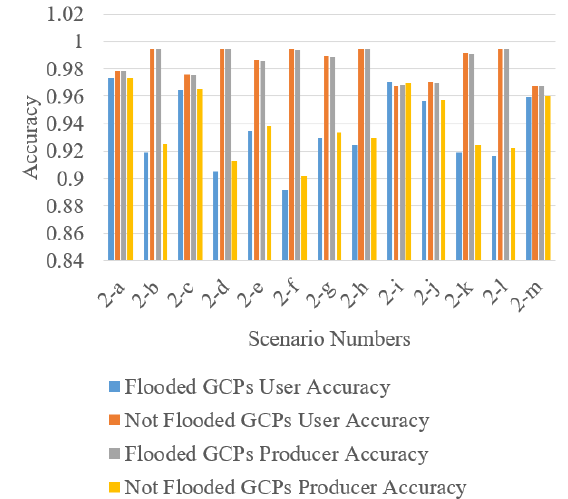
Figure 8. User and producer accuracy of flooded and not- flooded sample points